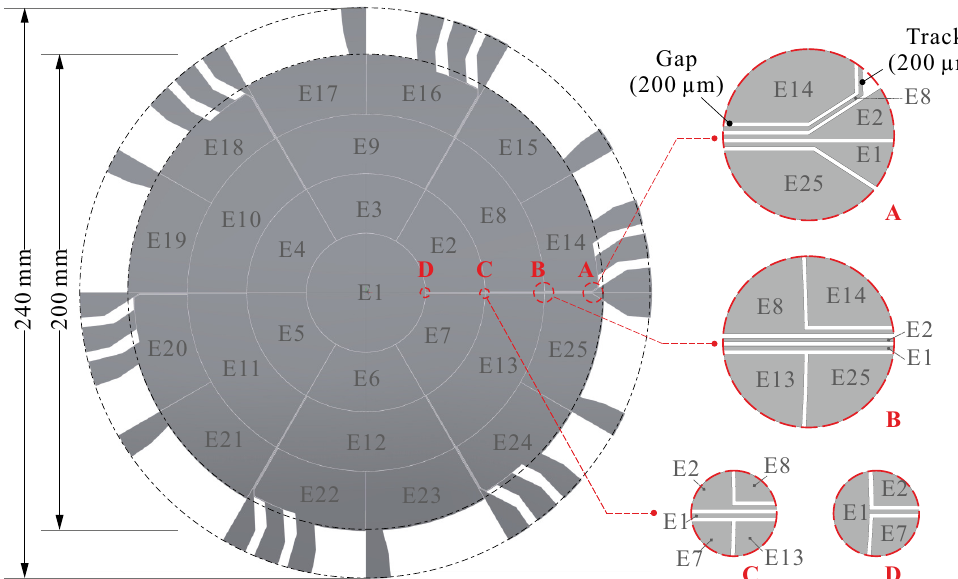
Figure 3. Keystone electrodes layout and electrical